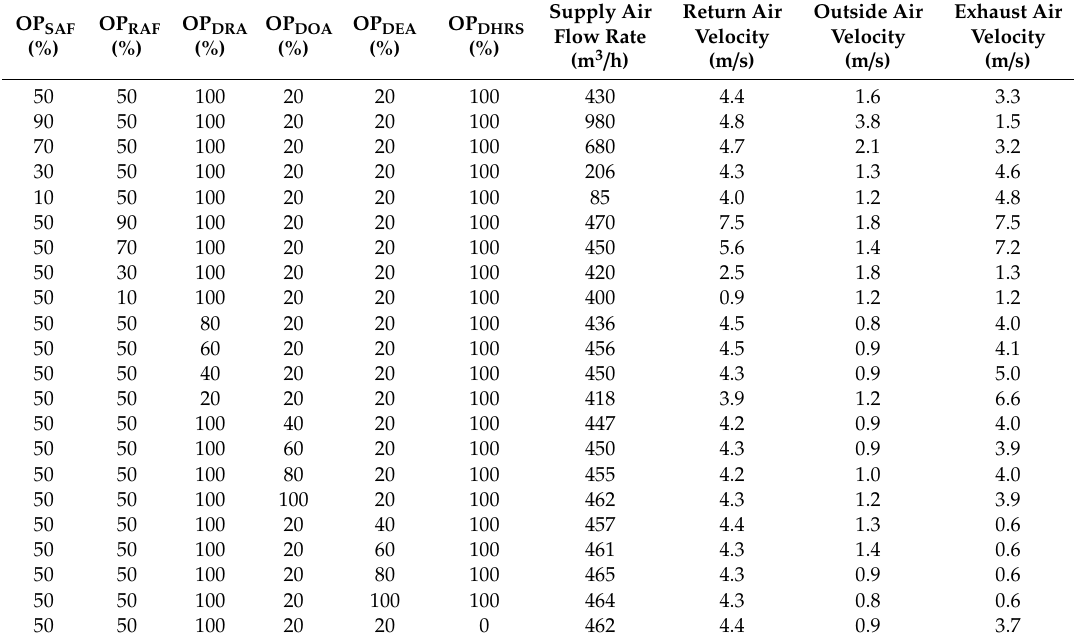
Table 5. Boundary conditions during the measurements of air velocity or volumetric flow